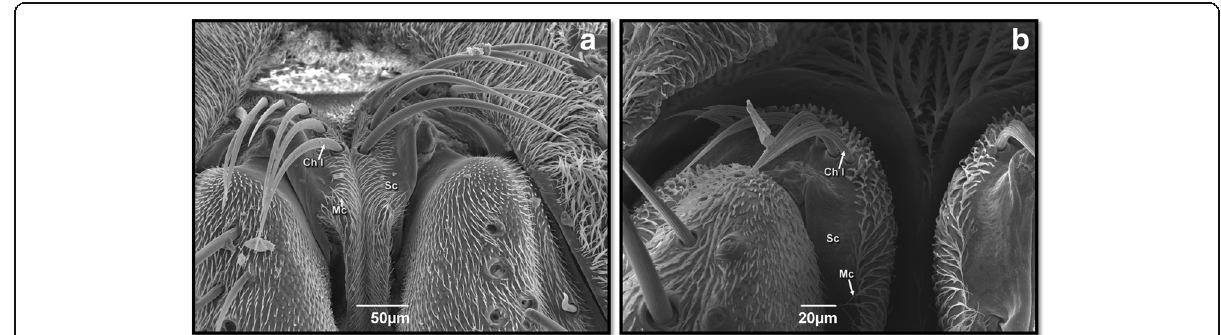
Fig. 5 Scanning electron micrographs showing the cuticular surface of scape in both genders of Mesembrinella bicolor : a female (× 330), b male (× 550). Sc = Scape; Ch I = chaetic sensilla; Mc = microtrichia